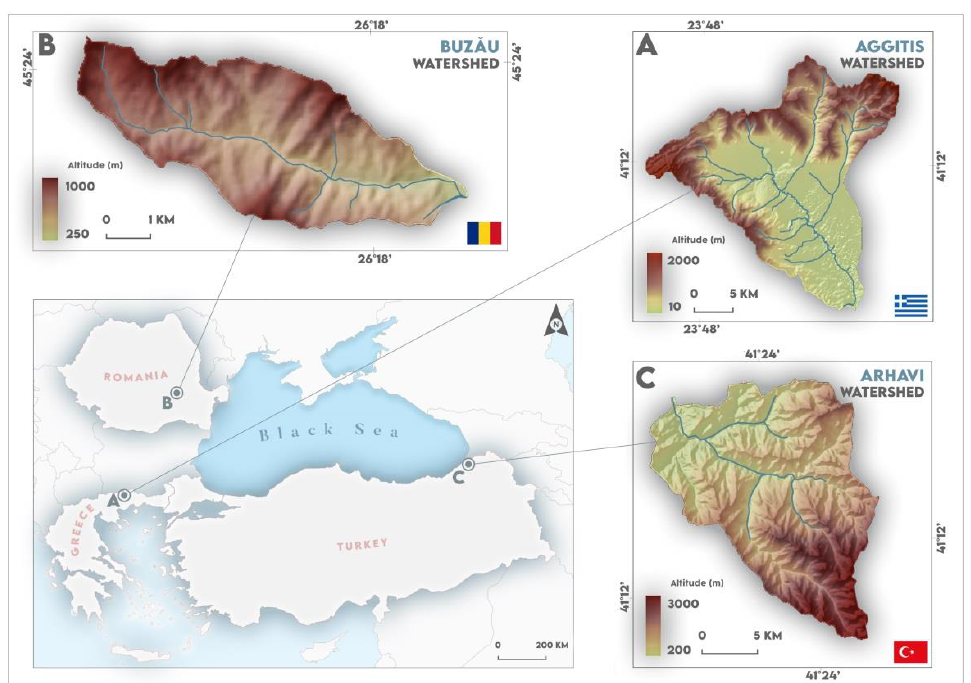
Figure 1. The three case study areas were located in ( A ) Aggitis River Watershed in Greece, ( B ) Buzau River Watershed in Romania, and ( C ) Arhavi River Watershed in Turkey.